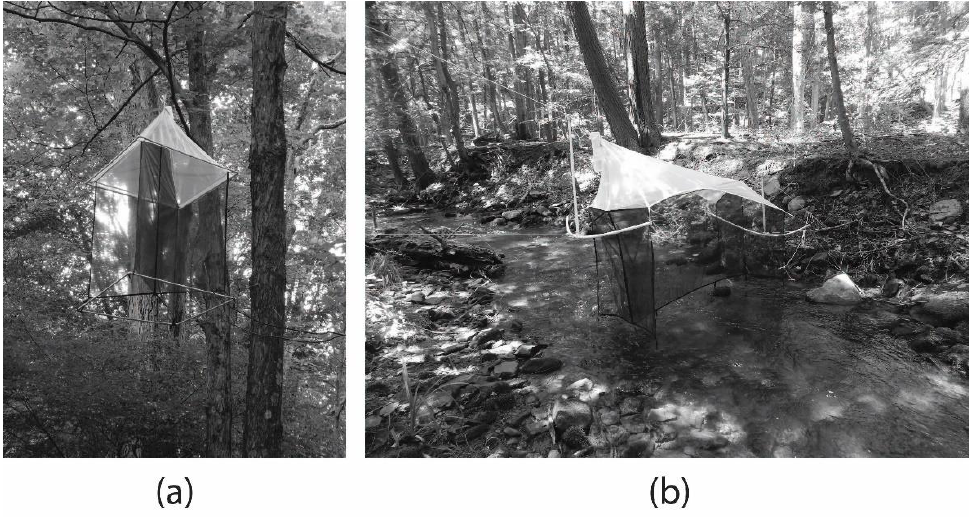
Figure 2. Images of a ( a ) malaise canopy trap and ( b ) Towns-style ground-level malaise trap. These are referred to as “canopy” and “ground” traps, respectively, for this study.